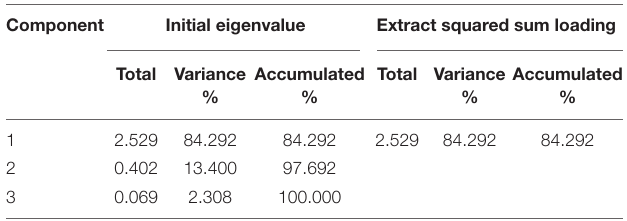
TABLE 14 | Component score coefficient matrix.